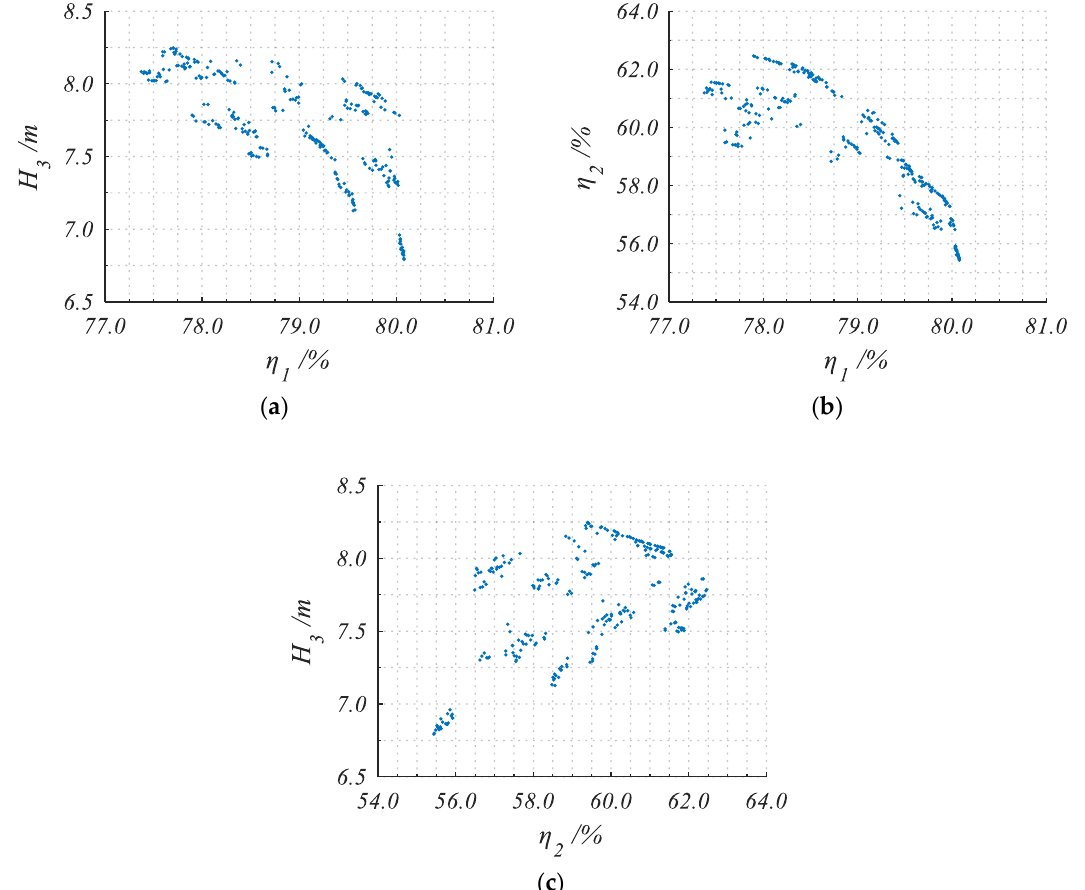
η η η 2 and ( c ) 2 – H 3 1 – H 3 ,, ( b ) 1 –